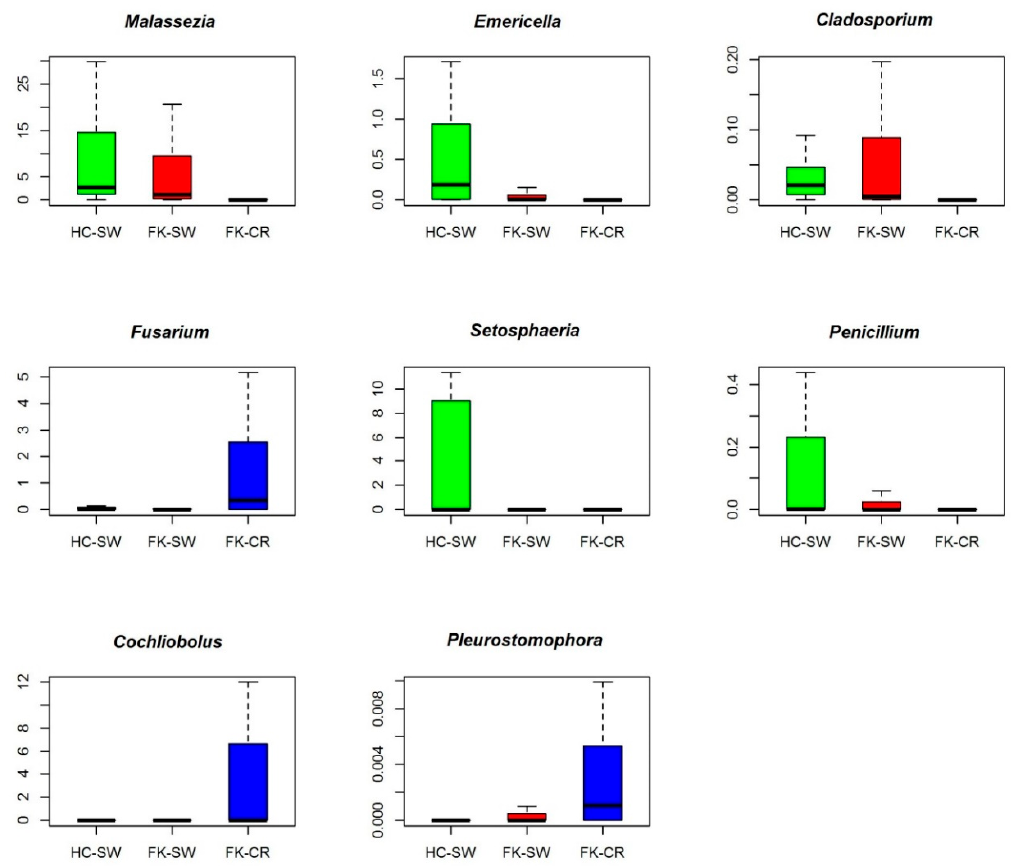
Figure 5. Fungal genera exhibiting significant (BH corrected p < 0.05) di ff erential abundance in ocular fungal microbiomes of healthy controls (HC-SW, n = 37) compared to microbiomes of fungal keratitis swabs and corneal scrapings (FK-SW, n = 23 and FK-CR, n = 29). Di ff erentially abundant genera having a median abundance of > 0.001% in at least one group of samples have been depicted. Median abundances (horizontal line) and interquartile ranges have been indicated in the plots.